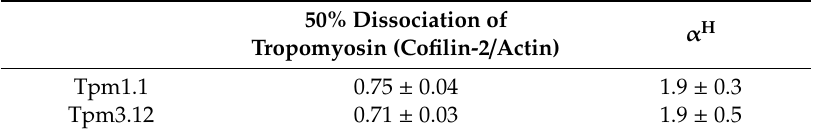
Table 3. Parameters of cofilin-induced dissociation of tropomyosin from